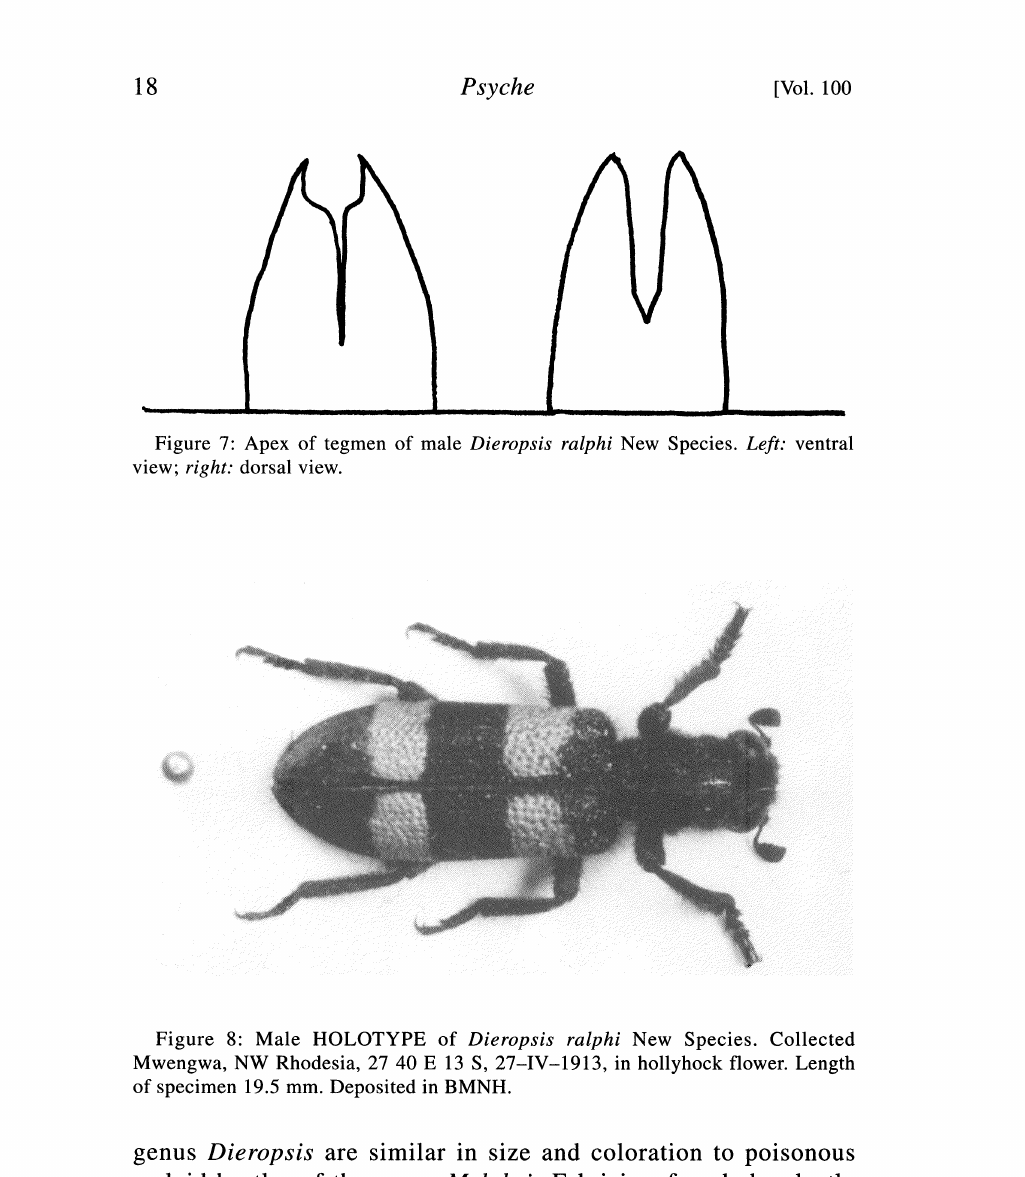
Figure 8" Male HOLOTYPE of Dieropsis ralphi New Species. Collected Mwengwa, NW Rhodesia, 27 40 E 13 S, 27-IV-1913, in hollyhock flower. Length of specimen 19.5 mm. Deposited in